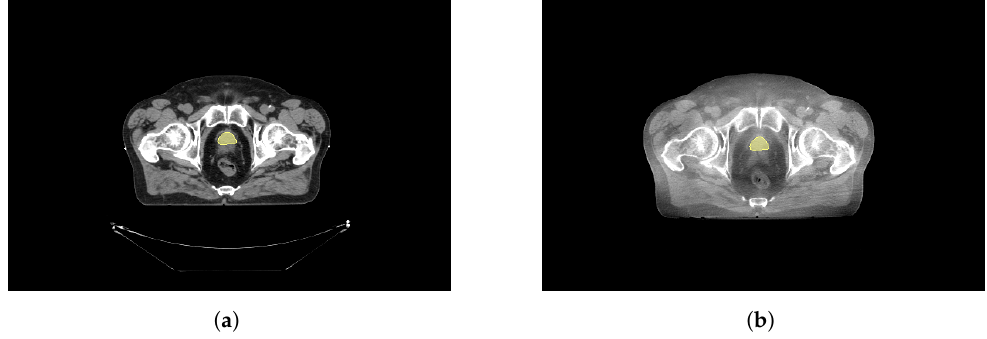
Figure 2. Initial CT scan with manually drawn prostate (yellow) and registered CBCT. ( a ) Initial CT scan. ( b ) First EBRT session CBCT.